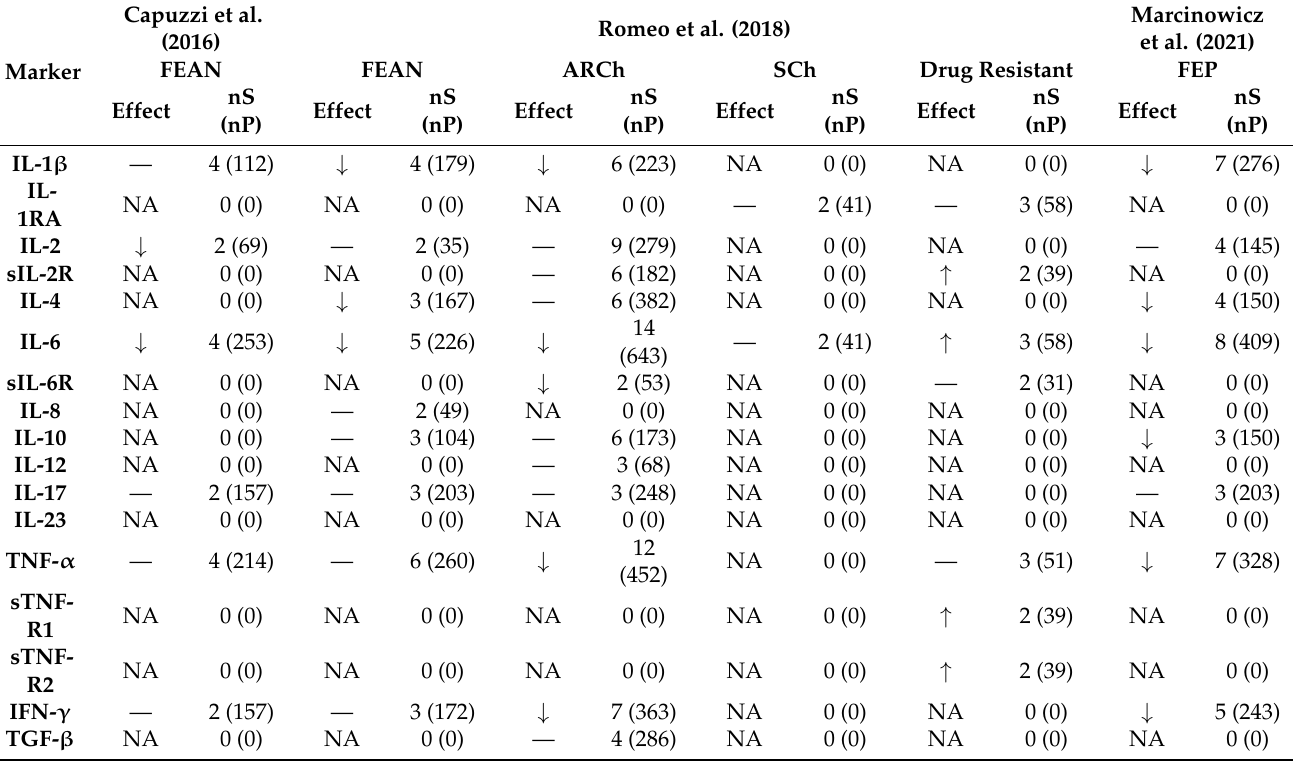
Table 5. Meta-analytical data concerning the effect of antipsychotics on peripheral cytokine levels in first episode psychosis (FEP), first episode drug naïve (FEAN), acute relapsed chronic (ARCh), stable chronic (SCh) and clinical high-risk or ultra-high risk (CHR/UHR) patients. Capuzzi et Marker